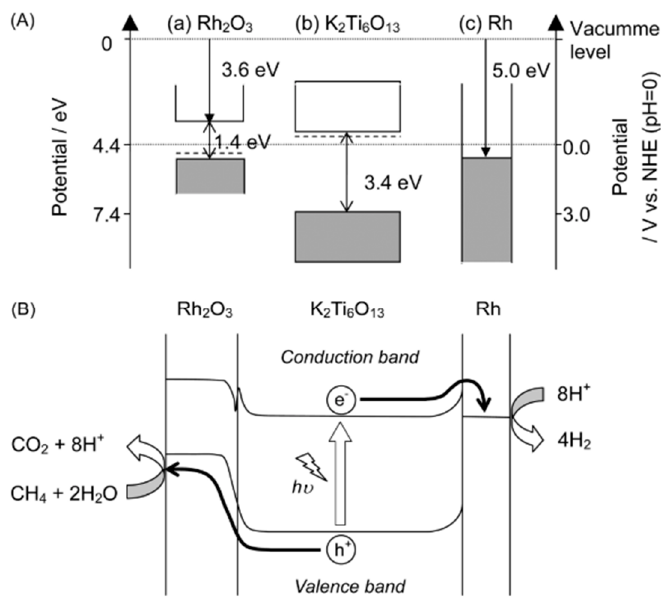
Figure 13. ( A ) Band structure of (a) Rh 2 O 3 , (b) K 2 Ti 6 O 13 , and (c) rhodium metal, and ( B ) the proposed mechanism of the photocatalytic steam reforming of methane over Rh/Rh 2 O 3 /K 2 Ti 6 O 13 . Reprinted with permission from [24]. Copyright (2012), American Chemical Society. NHE: normal hydrogen electrode.